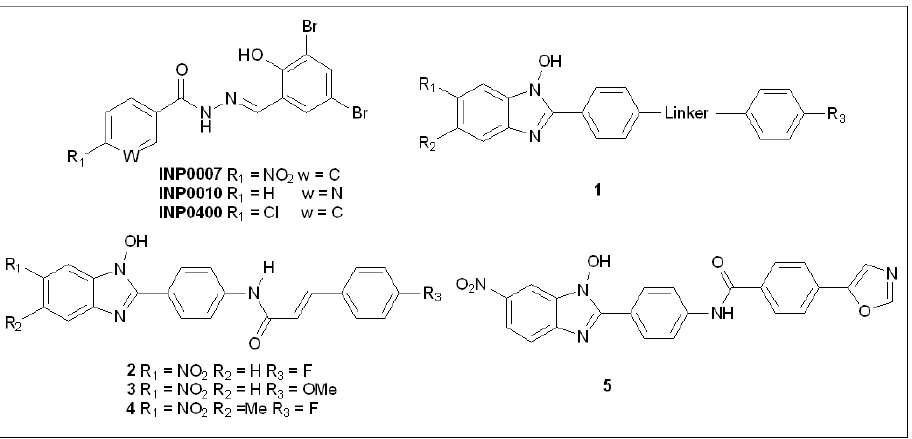
Figure 3. Structures of INP007, INP0010, INP 0400, and Compounds 1 – 5